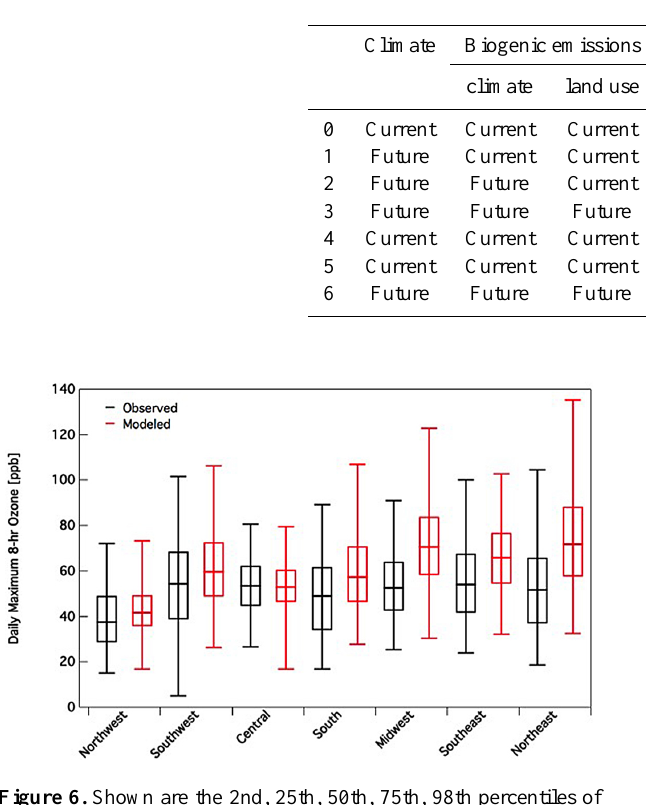
Figure 6. Shown are the 2nd, 25th, 50th, 75th, 98th percentiles of observed vs. modeled values of DM8O for each region.